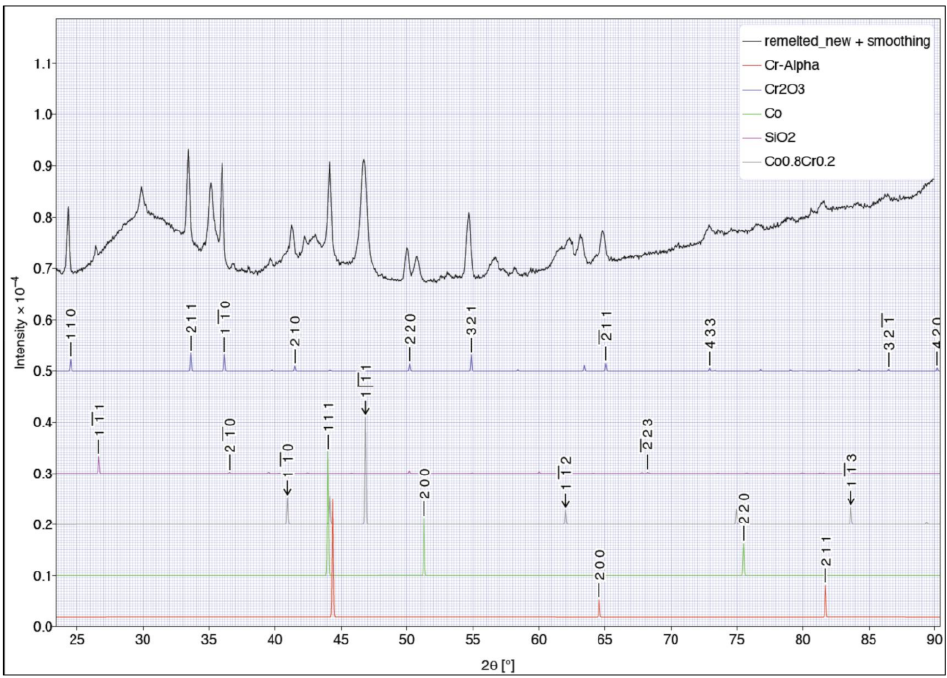
Figure 4. XRD analysis of the oxide remains in sample